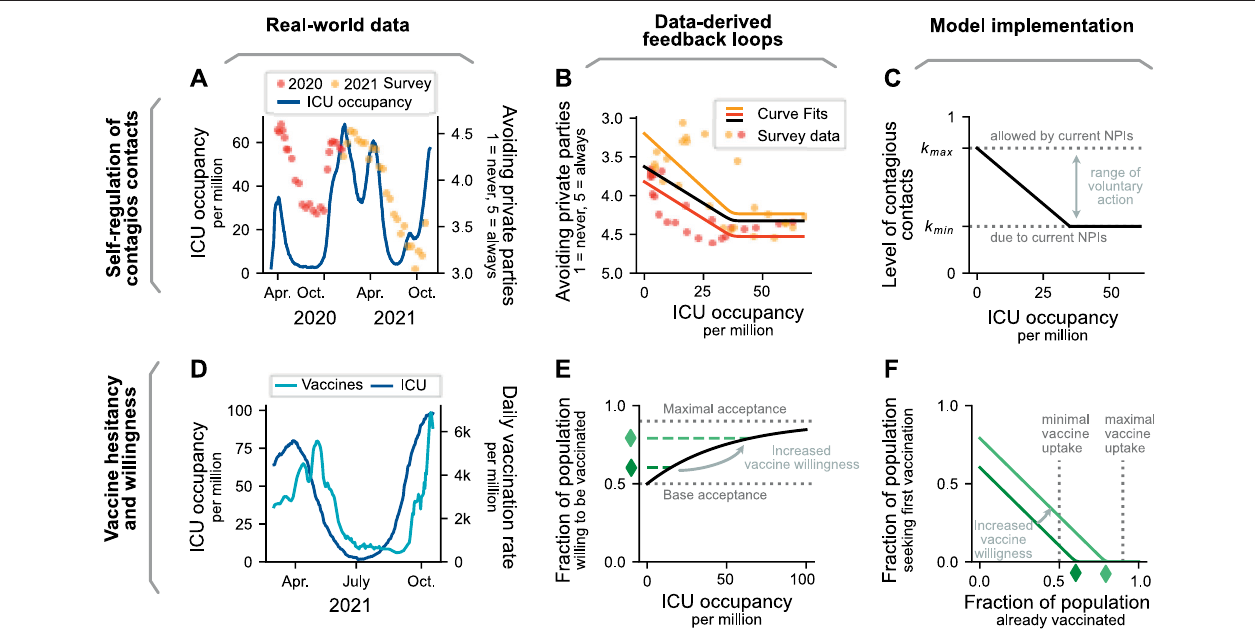
FIGURE2| Data-derivedformulationofbehavioralfeedbackloops. (A) :Reportedcontactreductionsfollowintensivecareunit(ICU)occupancyinGermany.Survey participants wereasked how likelythey weretoavoid private parties overthe courseofthepandemiconadiscretescalefrom 1(never) to5(always) [4].Todecouple the effect of vaccination availability, we present 2020 (red) and 2021 (yellow) data separately. Ticks indicate the middle of the month. (B) : The survey data on contact reduction and the ICU occupancy are related. The piece-wise linear relationship shows the reduction of contacts with increasing ICU occupancy, and for even higher ICU occupancy a saturation. Red, yellow, and black represent fi ts to the data from 2020, 2021, and overall, respectively. (C) : In the model, the contact reduction anditsdependencyonICUoccupancyisimplementedasamultiplicativereductionfactor k thatweighstheage-dependentcontextualcontactmatrices( Figure1B ). (D) : VaccineuptakeincreaseswithICUoccupancyinRomania(shownhere)andotherEuropeancountries( SupplementaryFigureS4 ). (E) :Willingnesstoacceptavaccine offer is modeled using an exponentially-saturating function, ranging between a lower and upper bound of acceptance depending on ICU occupancy. The bounds representthat afraction ofpeople iswilling tobe vaccinated evenat no immediate threat (noICU occupancy), and another fraction isnot willingorableto getvaccinated nomatterthethreat. (F) :Vaccinesaredeliveredatarateproportionaltothenumberofpeopleseekingavaccine,i.e.,thedifferencebetweenthenumberofpeoplewilling to be vaccinated and those already vaccinated. Thus, when the number of already vaccinated equals the number of people willing to get vaccinated, no more vaccinations are carried out. The same functional shape describes the booster uptake.